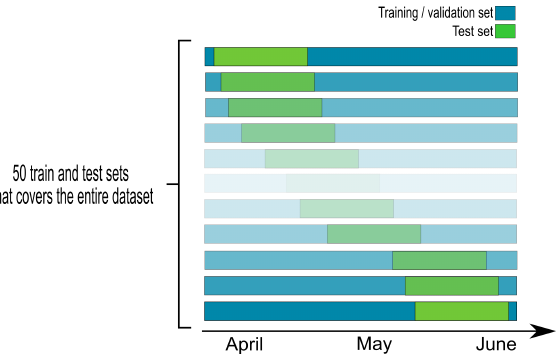
Figure A2. Diagram showing the process of training and evaluation of the model with 50 training and test sets covering the entire time series.